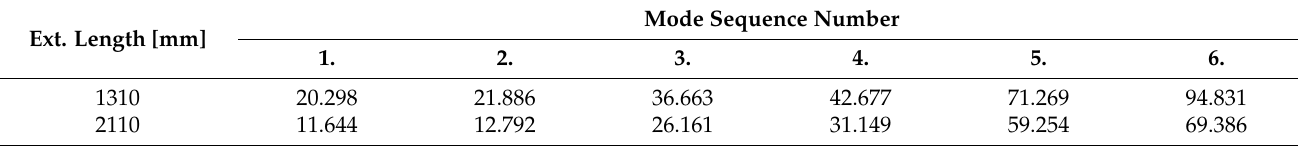
Figure 4. The first four mode shapes of the concept model of the adapter for case 1 of Table 4 according to the extension length of 1310 mm. Table 4. Comparison of natural frequencies (Hz) for the adapter according to the upper and lower limits of the extension length (the stroke length is 800 mm) applied for design purposes. Ext. Length